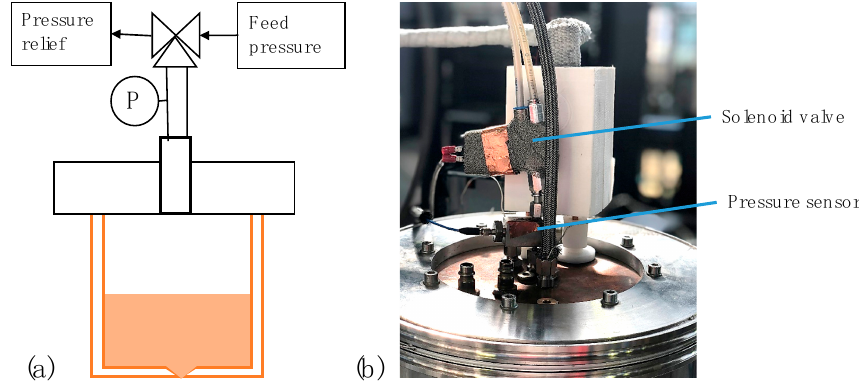
Figure 3. ( a ) Schematic view of the pressure sensor on the top plate of the droplet generator; ( b ) photo of the top plate of the droplet generator with removed cooling tubes.